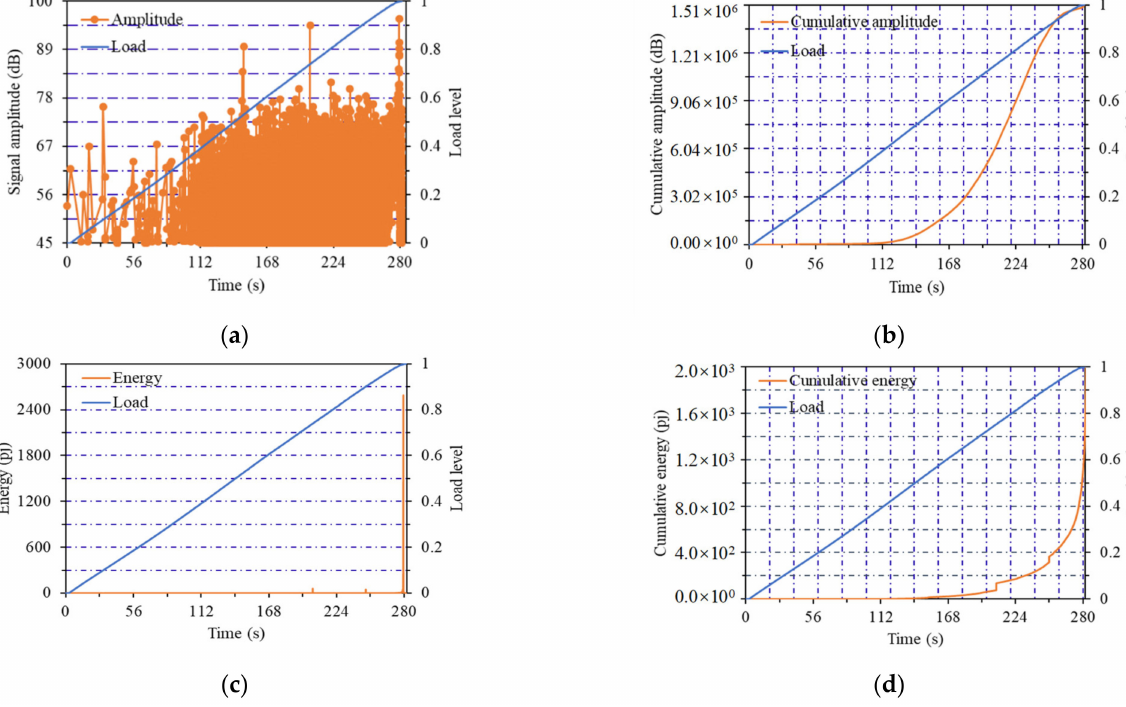
Figure 5. Curves of acoustic emission parameters of No.11 notched beam: ( a ) Amplitude curve; ( b ) cumulative amplitude curve; ( c ) energy curve; ( d ) cumulative energy